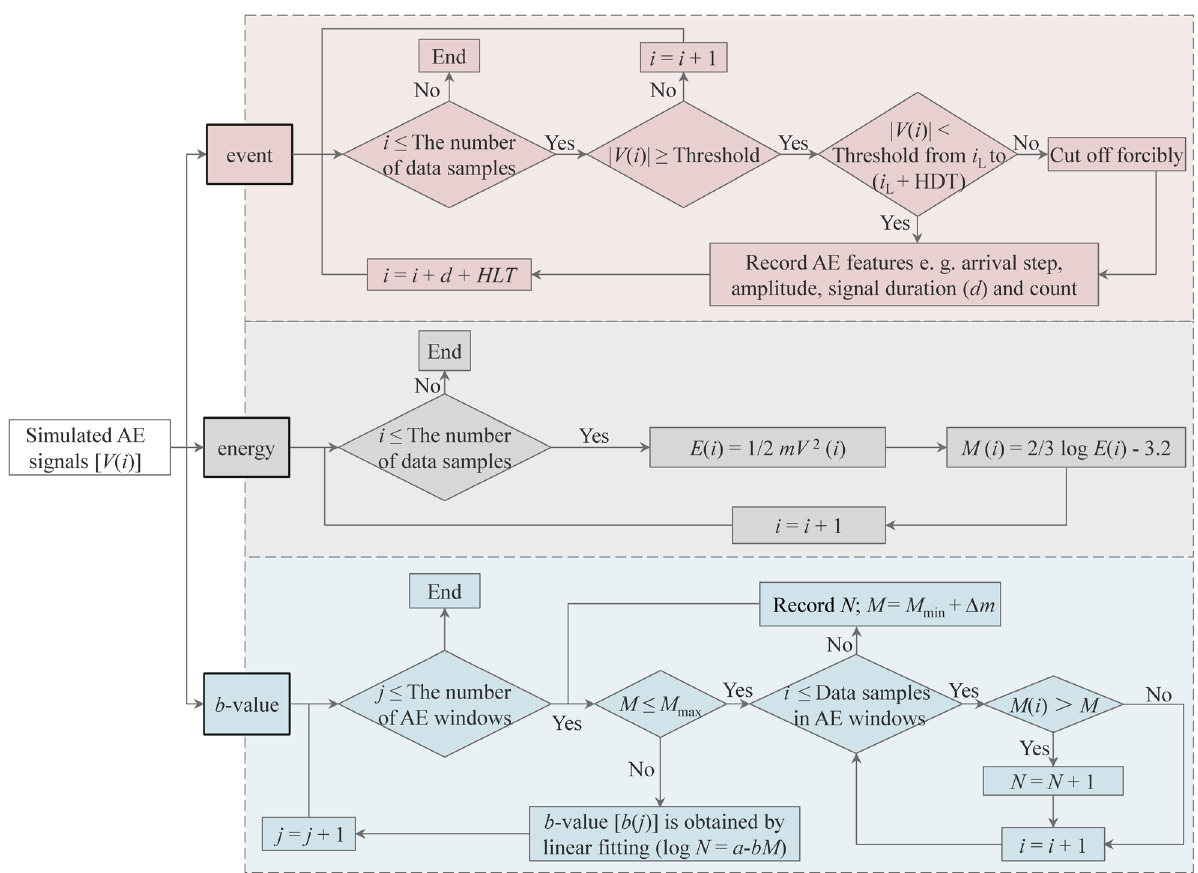
Figure 6. Flow chart of add-in code to calculate simulated AE characteristics. The simulated AE signal is represented by the normal velocity component V ( i ), which is imported into three calculation modules to obtain the event, energy and b -value, where i is the step rather than time, i L is the last threshold crossing step, d is the signal duration, HDT is the hit definition time, HLT is the hit lockout time, E ( i ) is the AE energy, m is the particle mass, M ( i ) is the magnitude, ∆ m is the magnitude interval, j is the number of AE windows, and N is the number of simulated magnitudes that exceed ( M + ∆ m As shown in Fig. 2c, the fracturing of the rock material is accompanied by the release of stored strain energy in the form of elastic waves. For the actual AE test, these elastic waves propagate inside the medium and can then be detected by AE sensors attached to the sample 56 . The PVBM complies with the rules of the experiment at most, that is, simulated AE signals are acquired by monitoring the normal particle velocity on the surface of a numerical model at each step in PFC 2D . The next step is to analyse the simulated AE signals. In an actual AE test, AE signals are analysed by a signal processor in the form of waveform analysis, of which a typical commercial software is AEwin developed by Physical Acoustics Corporation (USA). However, the simulated AE signals can- not be analysed directly by AEwin because the time evolution of PFC 2D is computed via the step 48 . Therefore, a series of add-in codes was developed by combining the principle of AEwin and the calculation characteristics of PFC 2D . Finally, we acquired simulated AE characteristics of a rock model, mainly including event, energy and b -value, which were designed in the following context (Fig. 6). For the simulated event, one or more predetermined evaluation thresholds should be set to identify simu- lated AE signals. When | V ( i )| exceeds the threshold, it marks the beginning of a simulated AE event, and i is determined as an arrival step. As the step increases, the last threshold crossing is recorded as V ( i L ). Next, judge whether this simulated event is over. The hit definition time (HDT) and Max duration are used to achieve this goal. If the threshold is not exceeded by | V ( i )| from i L to ( i L + HDT), it marks the end. The other case is that a simulated AE signal will be cut off forcibly when its length reaches the Max duration, which is often used in the acquisition of continuous signals or the stage of very intense signals. After confirming the end of a simulated event, other simulated AE features, such as signal duration ( d ) and amplitude, are recorded. To prevent reflec- tions of the former signal from being taken as a start of the next signal, hit lockout time (HLT) is defined. Finally, V ( i + d + HLT) will return to judge the next simulated event until all data have been calculated. For the simulated energy, the kinetic energy of particles can be determined explicitly in the DEM. The simu- lated b -value can be calculated by Eq. (5). Reasonable magnitude range [ M min , M max ] and AE windows, i.e., AE event segmentation should be predetermined to achieve this linear fitting. For data samples V (1) ~ V ( i ) in the j th AE windows, N is the number of simulated magnitudes that exceed ( M + ∆ m ), where ∆ m is the magnitude